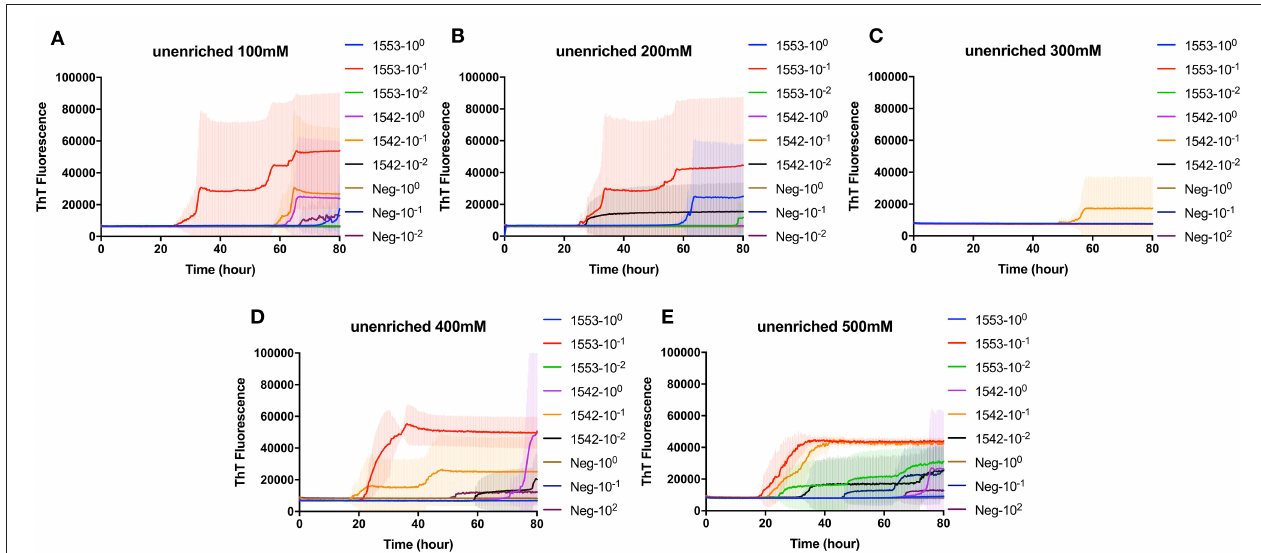
FIGURE 1 | Real-time quacking-induced conversion (RT-QuIC) reactions containing different NaCl concentrations (A) 100mM, (B) 200mM, (C) 300mM, (D) 400mM, and (E) 500mM seeded with fecal dilutions from chronic wasting disease (CWD) infected white-tailed deer brains using BV rPrP as a substrate. RT-QuIC reactions